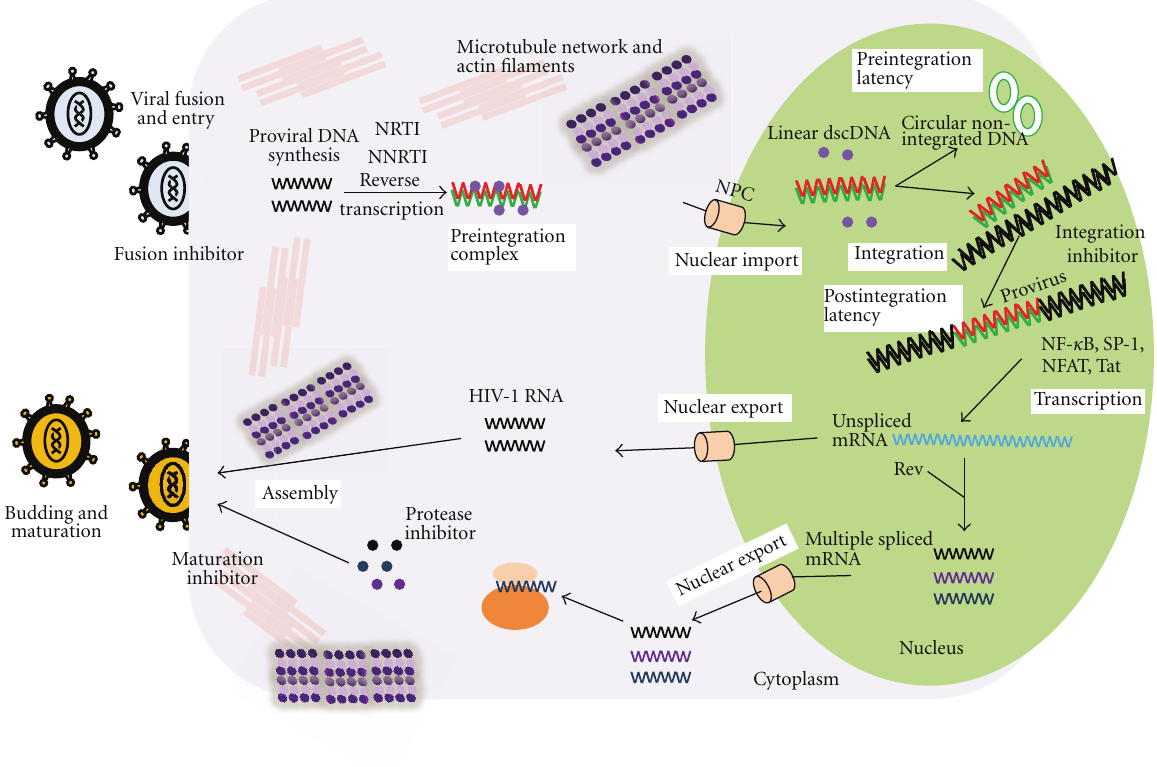
Figure 1: Schematic representation of HIV-1 life cycle and latency with current and possible targets for antiviral intervention. The HIV-1 life cycle begins with the attachment of virus to the receptor (CD4) and coreceptor (CXCR4 or CCR5), followed by fusion with target cell membrane. After virus entry, the viral nucleocapsid enter the cytoplasm, undergoes reverse transcription and then uses cytoplasmic dynein to move towards the nuclear pore complex. The preintegration complex is transported into nucleus through NPC, and then dscDNA either circulizes as one or two LTR containing circle or is integrated into a host cell chromosome. After integration the provirus remains quiescent in post integration latent state. On activation the viral genome is transcribed by cellular transcription factors, spliced mRNA are transported into cytoplasm where viral mRNA translated into regulatory and structural viral proteins. New virions assemble and bud through cell mem- brane, maturing through the activity of viral protease. The di ff erent classes of antiretroviral drugs are available. Fusion or HIV co-receptor inhibitors inhibit the entry of virions into a new target cell. The step of reverse transcriptase can be targeted, using nucleoside analogues or non-nucleoside reverse transcriptase inhibitors (NRTI and NNRTI, resp.). The HIV-1 integrase inhibitors inhibit the strand transfer reaction in the integration process, a crucial step in the stable maintenance of the viral genome, as well as e ffi cient viral gene expression and replication. The class of protease inhibitors interferes with the last stage of viral life cycle which results in the production of noninfectious viral particles. The HIV maturation inhibitors disrupt a late step in HIV-1 Gag